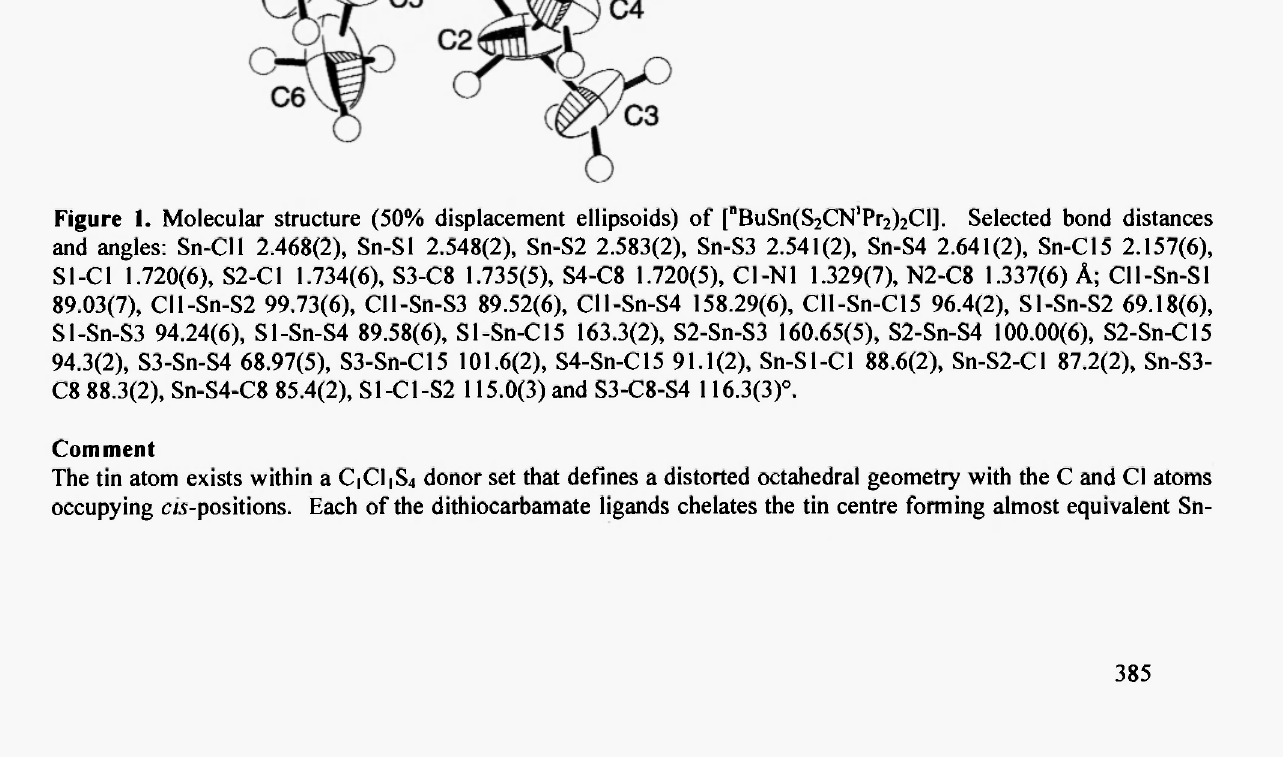
Figure 1. Molecular structure (50% displacement ellipsoids) of [ n BuSn(S 2 CN'Pr2)2Cl]. Selected bond distances and angles: Sn-CIl 2.468(2), Sn-Sl 2.548(2), Sn-S2 2.583(2), Sn-S3 2.541(2), Sn-S4 2.641(2), Sn-C15 2.157(6),